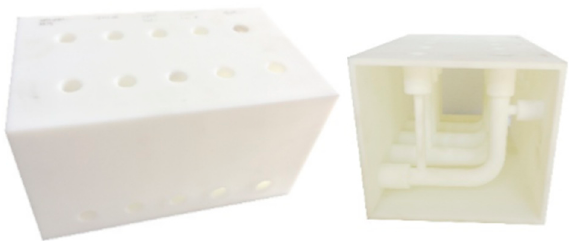
Figure 21. AMed manifold using stereolithography (SLA).